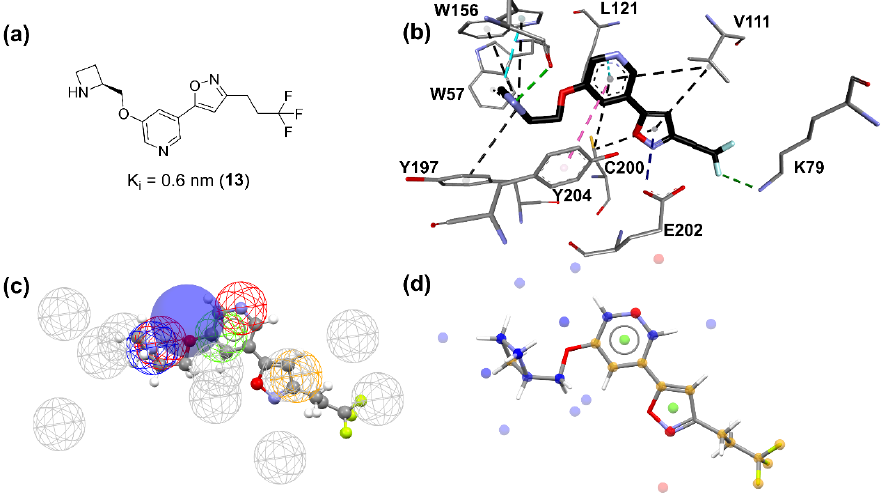
Figure 5. Characteristics and docking pose of ligand 13 . ( a ) 2D structure, ( b ) best docking pose and its interactions with ( α 4) 2 ( β 2) 3 orthosteric site, ( c ) 13 structure in pharmacophore map, ( d ) 13 structural and molecular features. ( b ) Nitrogen atoms are shown in blue, oxygen atoms in red, fluorine atoms in light blue, hydrogen atoms are omitted for clarity and carbon atoms in gray (amino acids) or black (ligand). Molecular interactions are shown as dotted lines: hydrogen bonds in green, π -anion in dark blue, π -sigma in cyan, π - π stacked in pink, and π -alkyl in black. ( c ) Meshed spheres are shown as follows: exclusion spheres in gray; hydrogen bond acceptor regions in red; planar rings in light green; hydrophobic regions in yellow; hydrogen bond donor regions in blue. Blue opaque spheres represent directions of hydrogen bond donor atoms. ( d ) Small spheres represent molecular features and are shown as follows: proton acceptor regions in red; planar rings in light green; hydrophobic regions in yellow; hydrogen bond donor regions in blue.